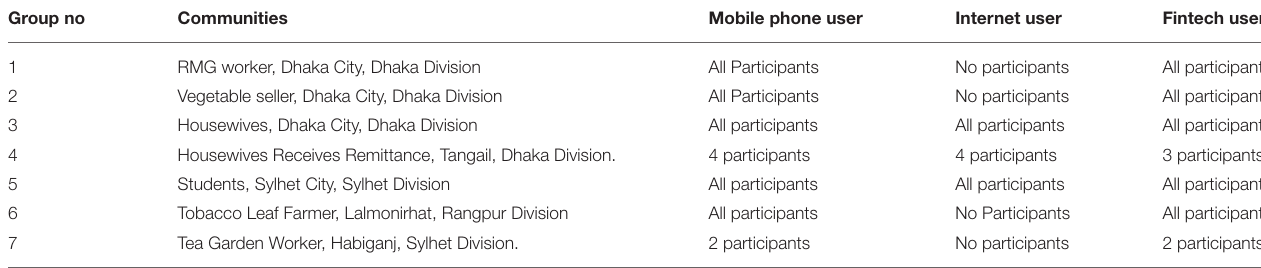
TABLE 4 | Participants’ mobile phone, internet, and fintech usage during COVID-19. Group